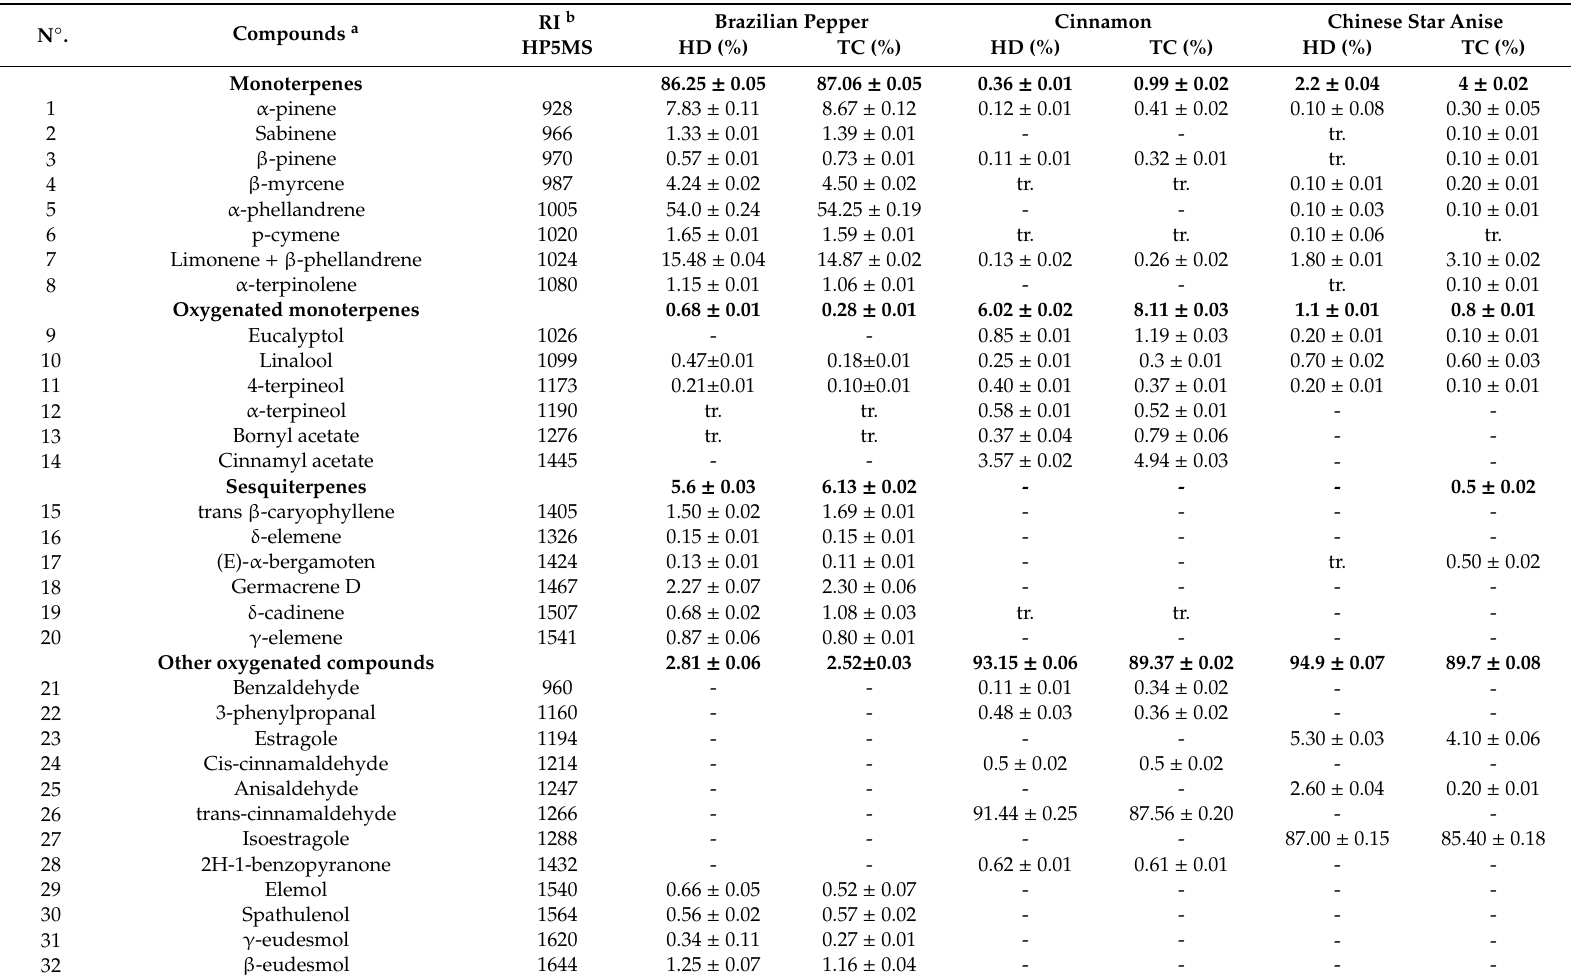
Table 1. Chemical compositions of three essential oils obtained by turbo-Clevenger (TC) and hydrodistillation (HD). N ◦